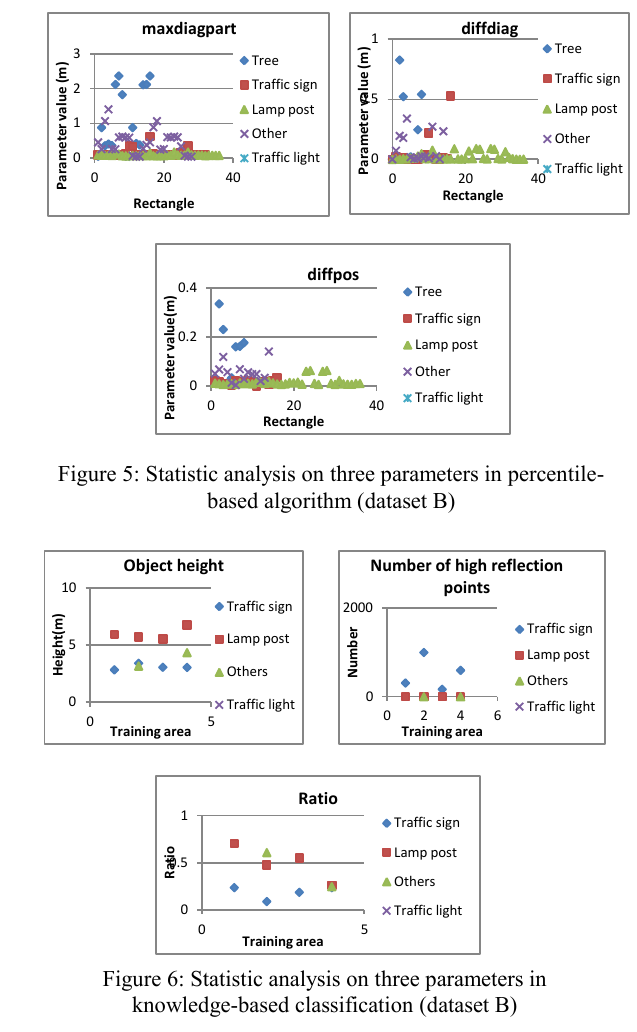
Figure 4: Statistic analysis on four parameters in rule-based algorithm in four training areas (dataset B)